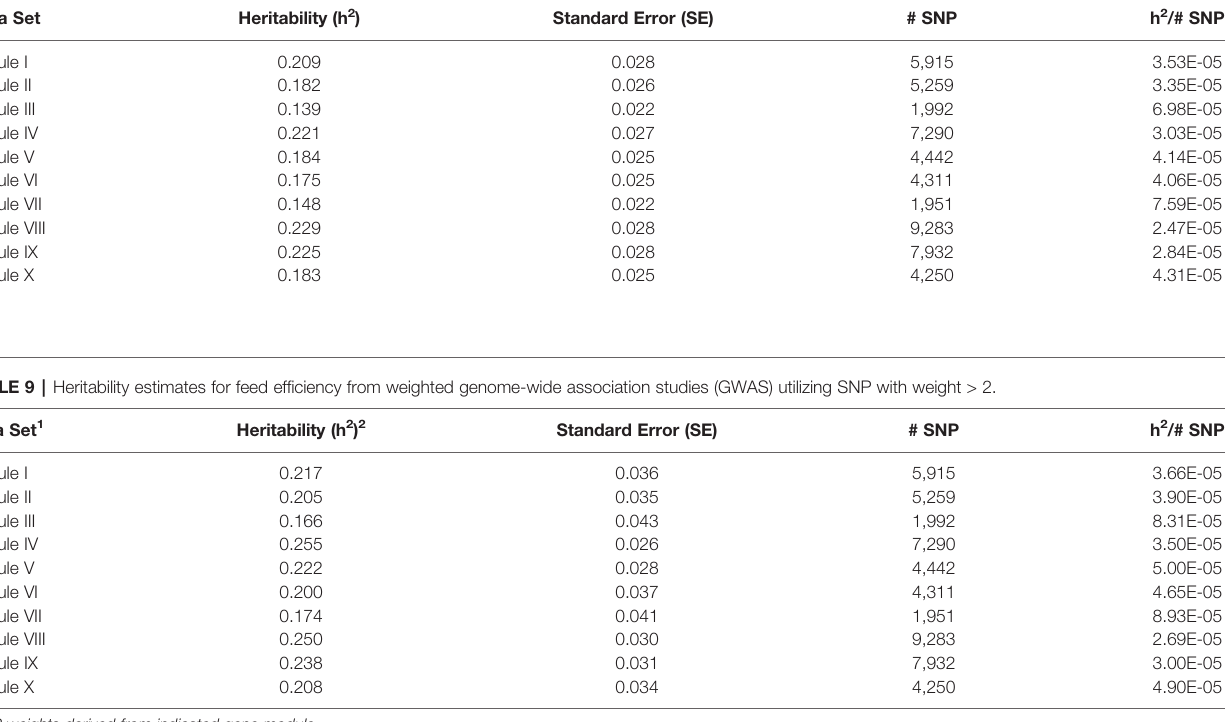
TABLE 8 | Heritability estimates for feed ef fi ciency from unweighted genome-wide association studies (GWAS) utilizing SNP with weight > 2. Data Set